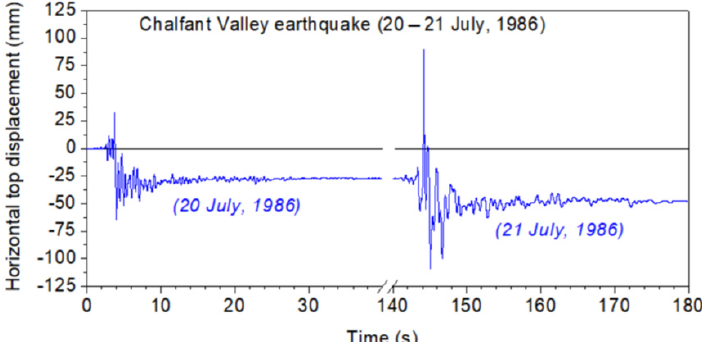
Figure 10. Soil – pile – platform system under the Chalfant Valley earthquake (20 – 21 July 1986): time history of the horizontal top displacement.